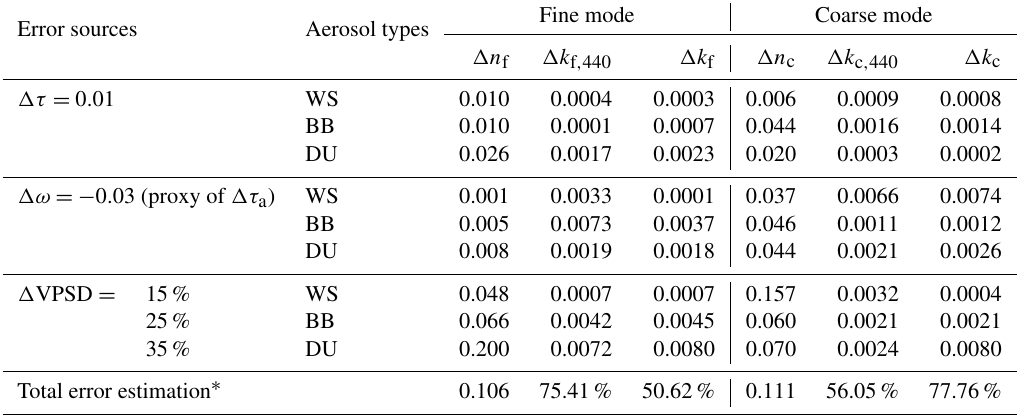
Table 2. Typical uncertainties on the estimated complex refractive indices of fine (f) and coarse (c) modes. Three error sources (on τ , τ a and VPSD, respectively) and three aerosol types (WS: water soluble, BB: biomass burning, DU: dust) are